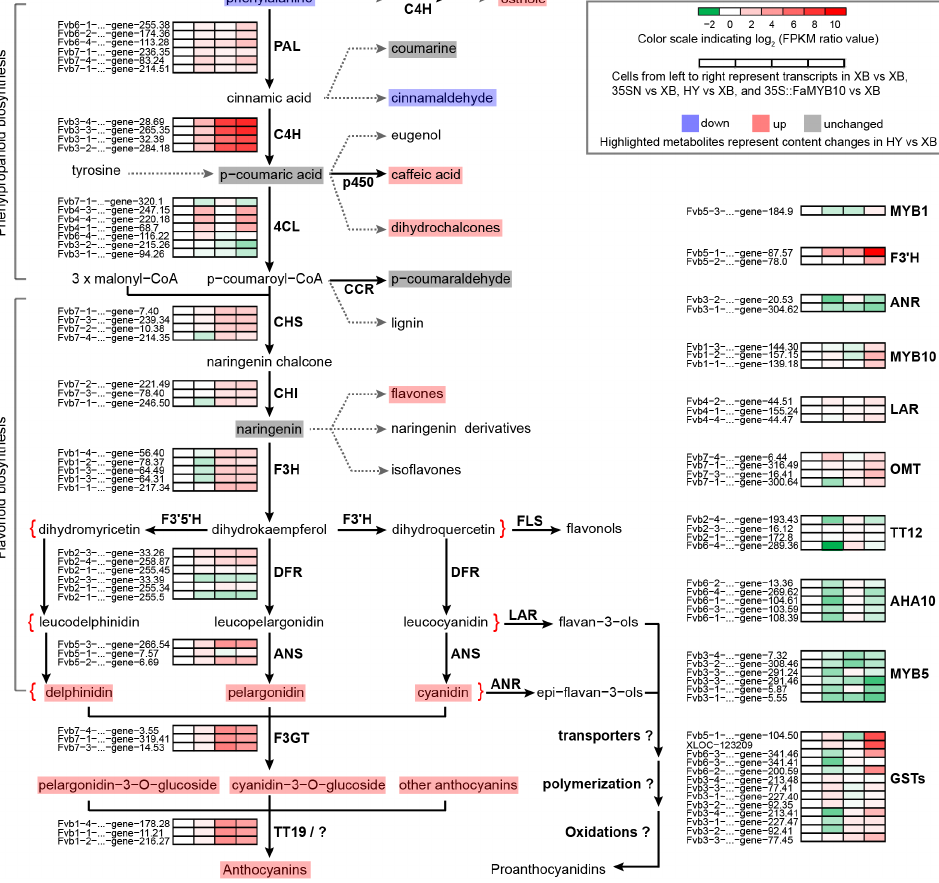
Figure 2. Schematic of flavonoid biosynthesis pathway in Benihoppe (HY) and Xiaobai (XB) strawberries. Four cells from the left to right represented transcripts in XB vs. XB, 35SN vs. XB, HY vs. XB, and 35S::FaMYB10 vs. XB, separately. The cell color indicated log2 FPKM ratio values from − 2 (green) to 10 (red), and transcripts change trends were shown as a heatmap with abbreviated genes name on the left. The highlighted metabolites represented that they were detected by targeted metabolomics or quasi-targeted metabolomics, and the color showed the content changes in metabolites in HY vs. XB, with light blue (down), pink (up), and light grey (unchanged).